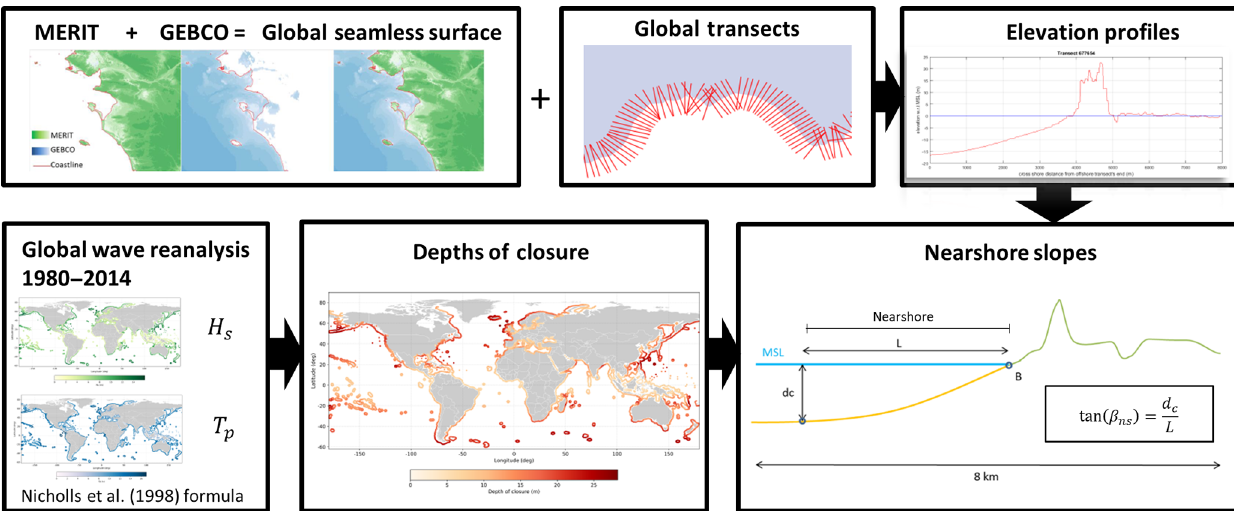
Figure 1. Work flow followed for the calculation of the nearshore slopes worldwide.